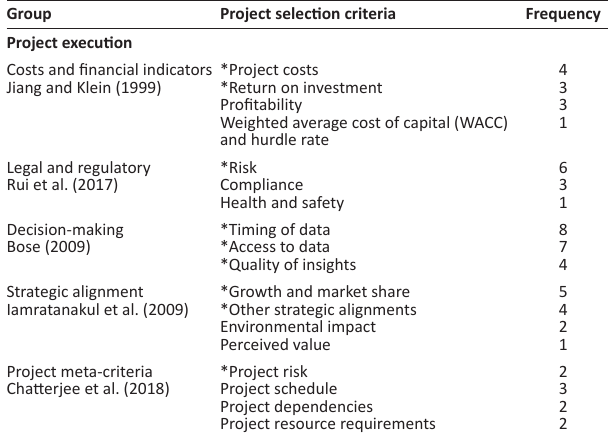
Table A-1 (Continues...): Project selection criteria from interviewees. Group Project selection